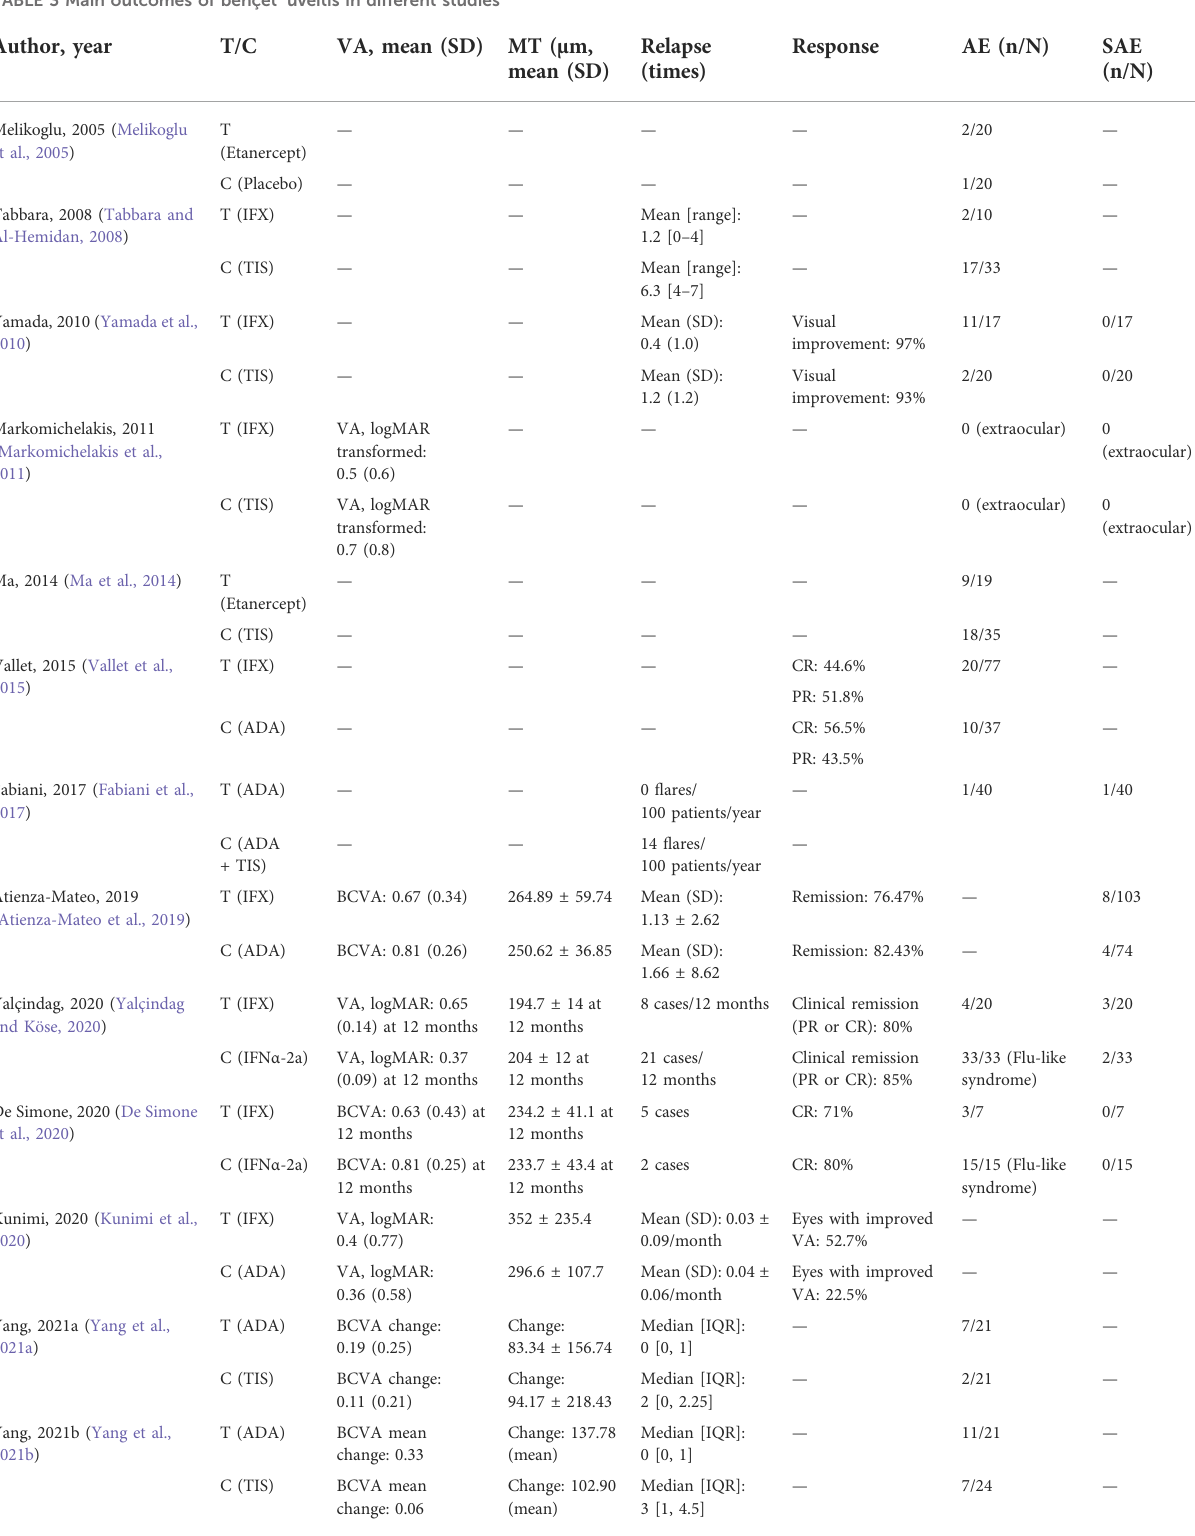
BCVA mean change: 0.06